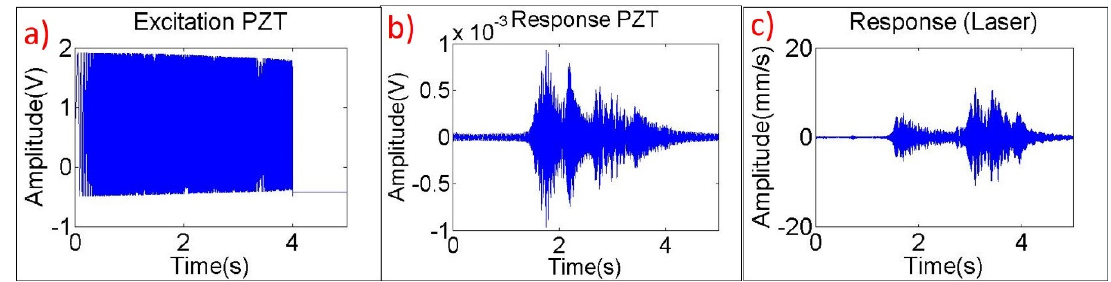
Figure 10. Time signals. ( a ) Signal PZT exciter, ( b ) Signal PZT sensor, ( c ) Signal Laser.